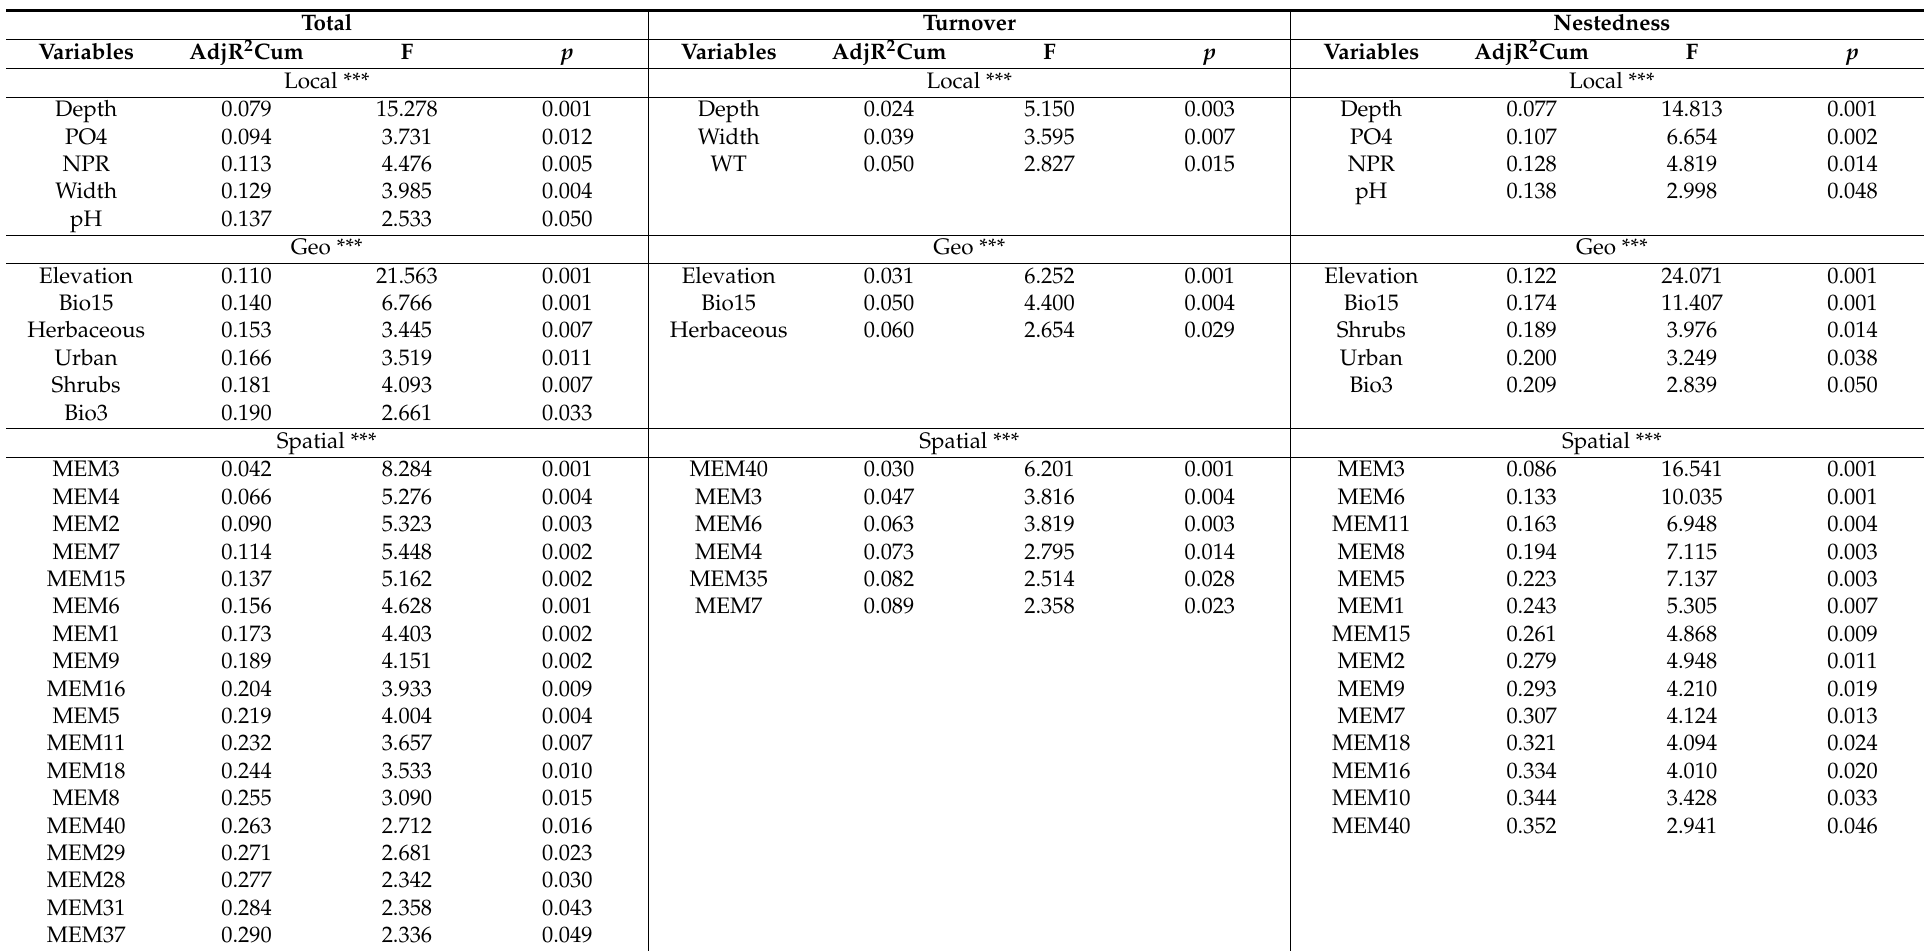
Table 4. The local environmental (Local), geo-climatic (Geo), and spatial (Spatial) variables that were selected for the phylogenetic β -diversity component, respectively. Each variable is displayed in the order in which it was selected. F, p, and AdjR 2 Cum values are displayed. None of the selected variables